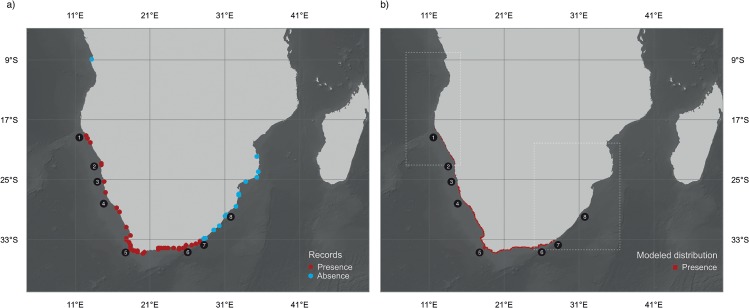
(a) Records of occurrence for M. galloprovincialis throughout the southern African coast (Red dots for presence and blue dots for absence). (b) Reclassified ensemble showing the occurrence of M. galloprovincialis for the present (2000–2010). Numbers show Regions Of Interest: ROI 1. Rocky Point, ROI 2. Walvis Bay, ROI 3. Sossusvlei, ROI 4. Elizabeth Bay, ROI 5. Cape Town, ROI 6. Port Elizabeth, ROI 7. East London, ROI 8. Durban. The dashed squares indicate those regions where the Lagrangian Particle Simulations where performed: the west coast, from Capulo to Walvis Bay, and the southeast coast, from St Francis Bay to Beira. Credits for the background of both maps: General Bathymetric Chart of the Oceans (GEBCO).